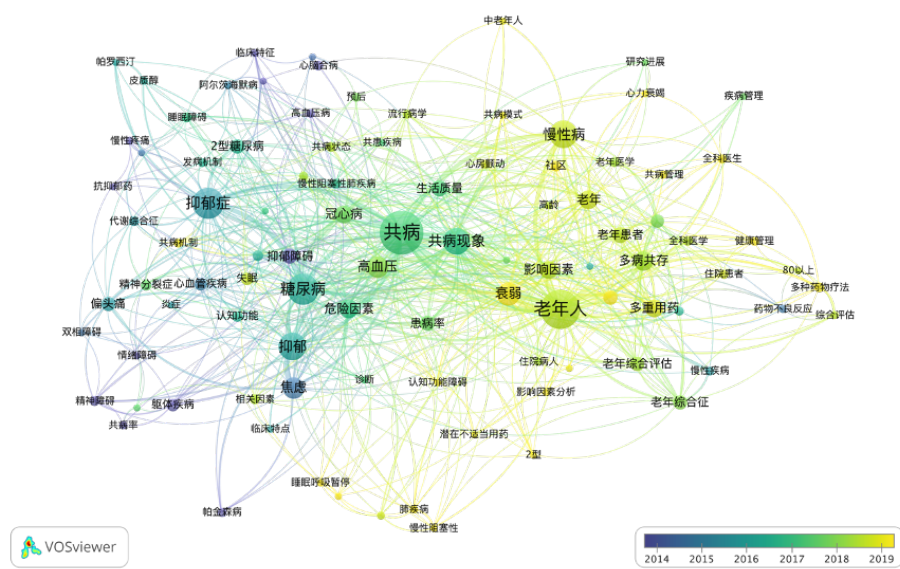
Figure 10. Burst keywords analysis of Chinese high-frequency.